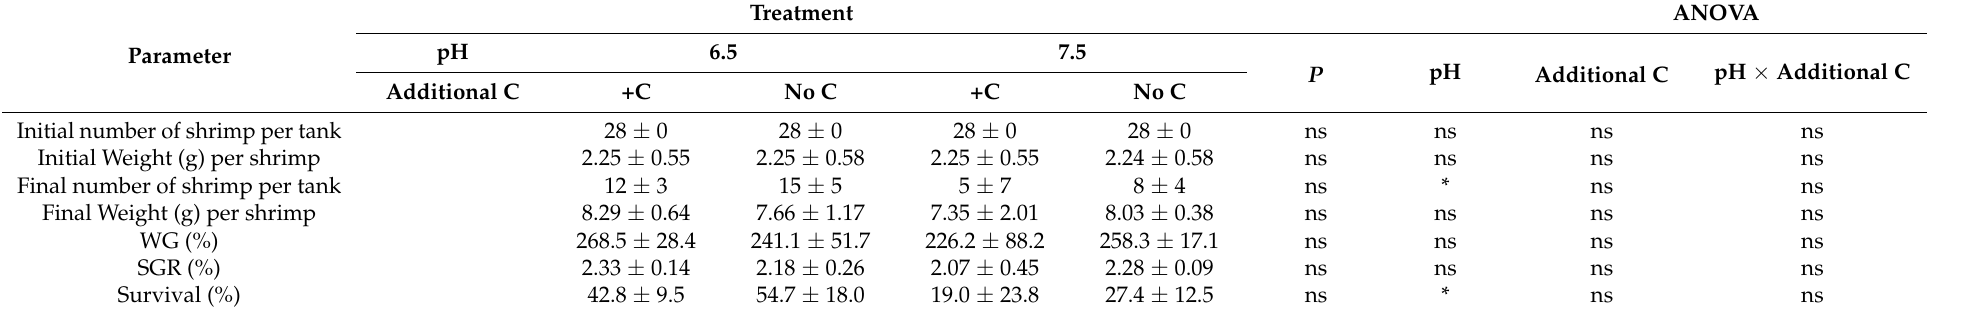
Table 1. Response of shrimp grown in marine aquaponics at two pH levels with or without additional carbon for 8